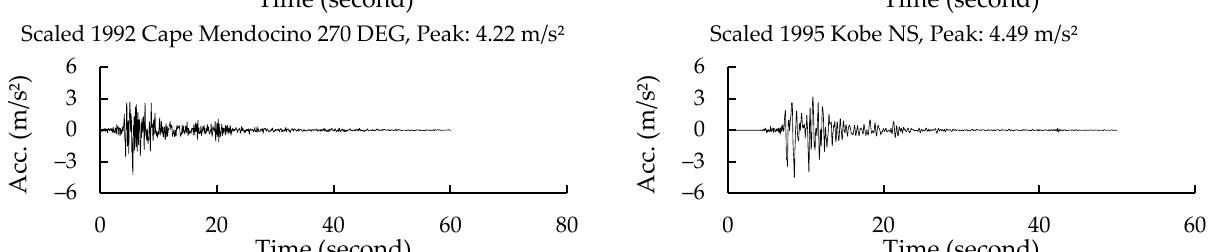
Figure 15. Original ten time history acceleration waves of earthquake motions.